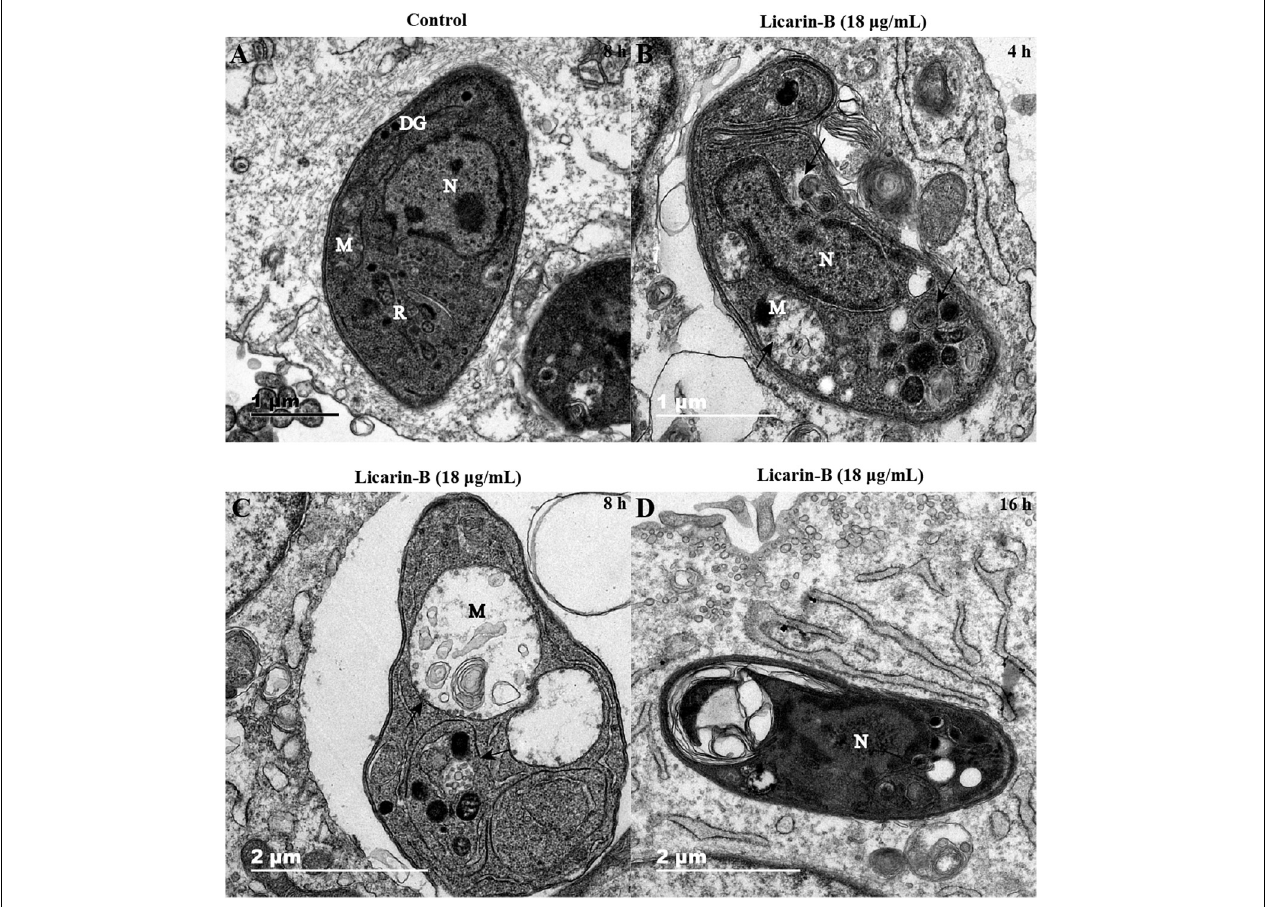
FIGURE 5 | Ultrastructural changes in T. gondii tachyzoites after licarin-B. HFFs were infected with 1.5 × 10 6 T. gondii tachyzoites; 18 µ g/mL licarin-B was then added, and the cells were cultured for 4, 8, or 16 h. In the control group, the well-preserved tachyzoite structures were maintained, including the rhoptries (R), dense granules (DGs), nucleus (N), and mitochondrion (M) (A) . Licarin-B treatment of the parasites for 4 h induced cytoplasmic alterations, such as slight mitochondrial swelling and a double membrane structure (B) . After 8 h of incubation, licarin-B induced aggravated mitochondrial swelling, disrupted cristae, vacuole formation, and autophagy-like double membrane structures in the cytoplasm (C) . Furthermore, extensive clefts around the nucleus, nuclear membrane disappearance, and progressive degeneration of the parasites were observed after 16 h incubation with licarin-B (D) . Scale bars: 1 µ m (A,B) ; 2 µ m (C,D)